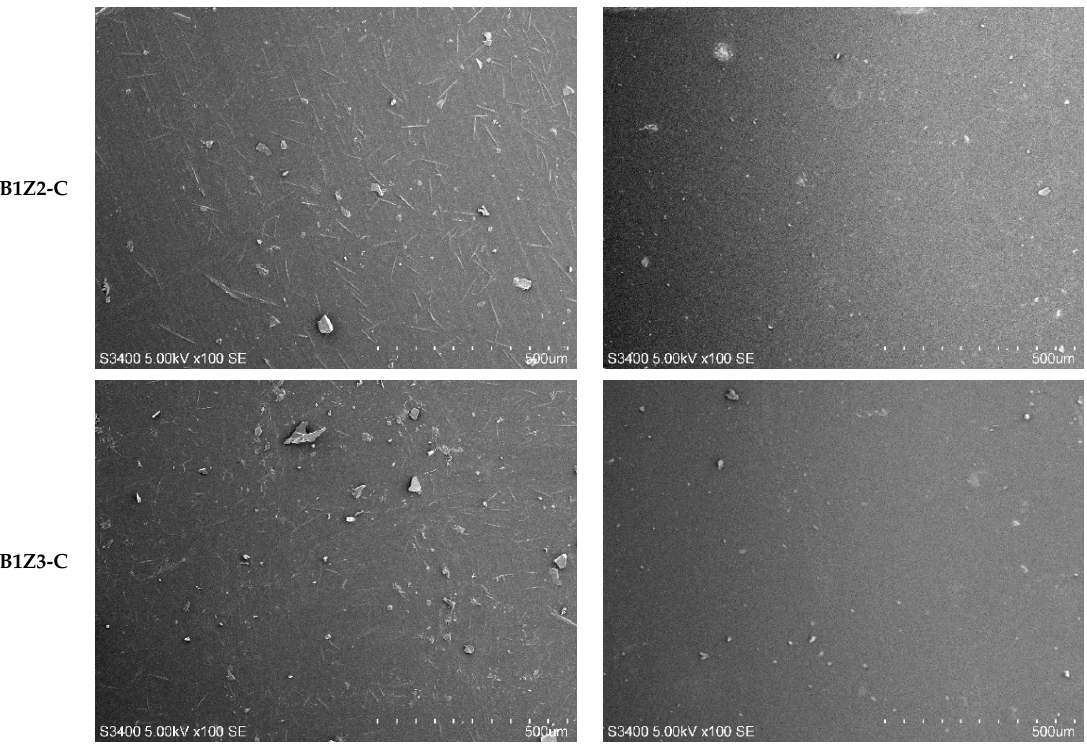
Figure 5. SEM images of the films with di ff erent formulations before and after